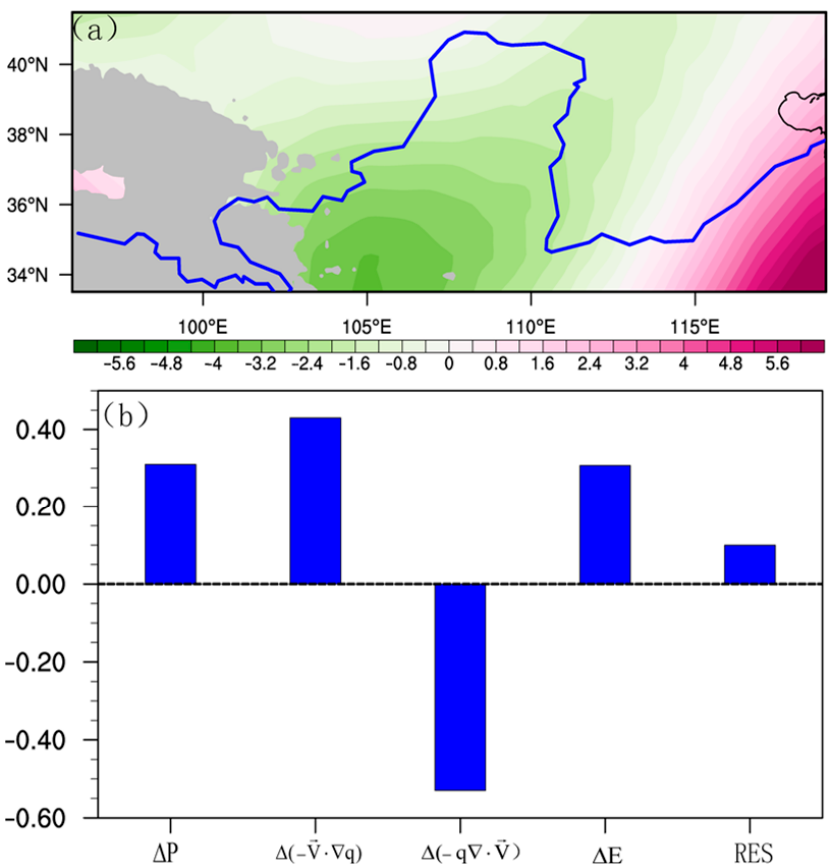
Figure5. ( a )Futurechangesinthetotal-columnmoisturefluxconvergence(shaded; units:10 − 5 kgm − 2 s − 1 ) in summer projected by the selected CMIP6 models under SSP5-8.5 during the latter half period of the 21st century relative to the historical mean. The blue line indicates the Yellow River. Grey shading denotes the TP. ( b ) Future changes of summer precipitation over the YRB projected by the selected CMIP6 models under SSP5-8.5 during the latter half period of the 21st century relative to the historical mean, and the relative contributions of moisture advection, moisture convergence, surface evaporation, and residual term to projected summer precipitation changes over the YRB. Units: mm d − 1